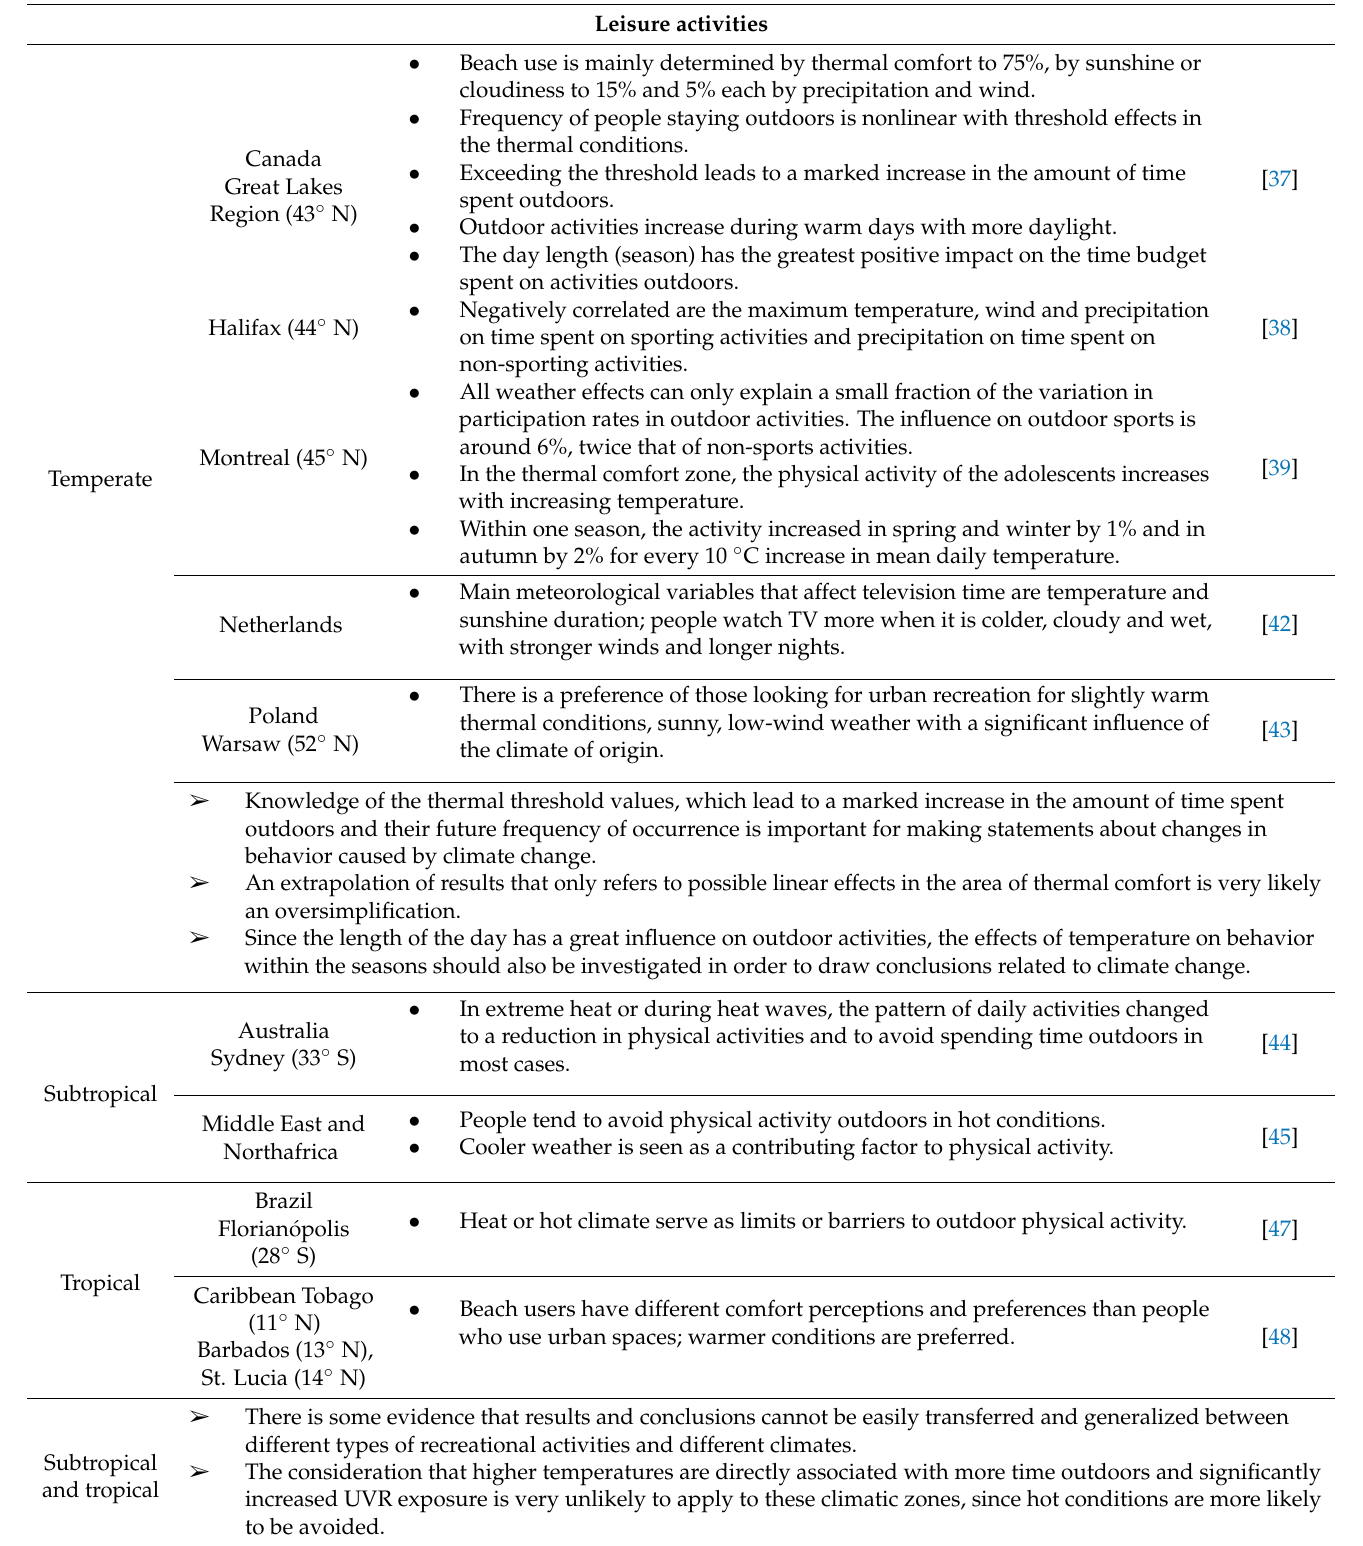
Table 4. Summary of the key messages and conclusions from the type II studies differentiated according to leisure activities, active mobility and use of public space. Key Messages (Bullet Points) and Conclusions (Bullet